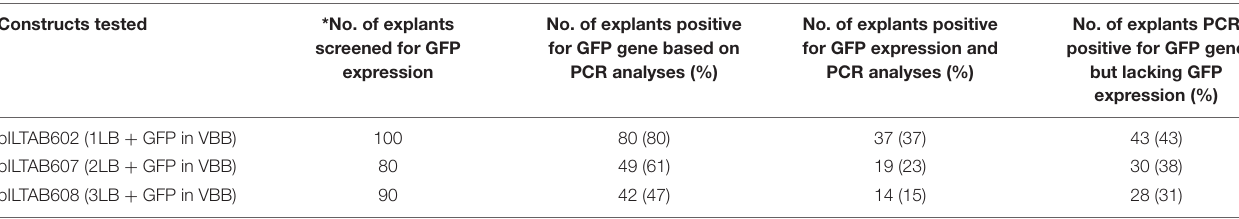
TABLE 1 | Comparison between VBB detection through PCR and GFP expression in transgenic cassava callus. Constructs